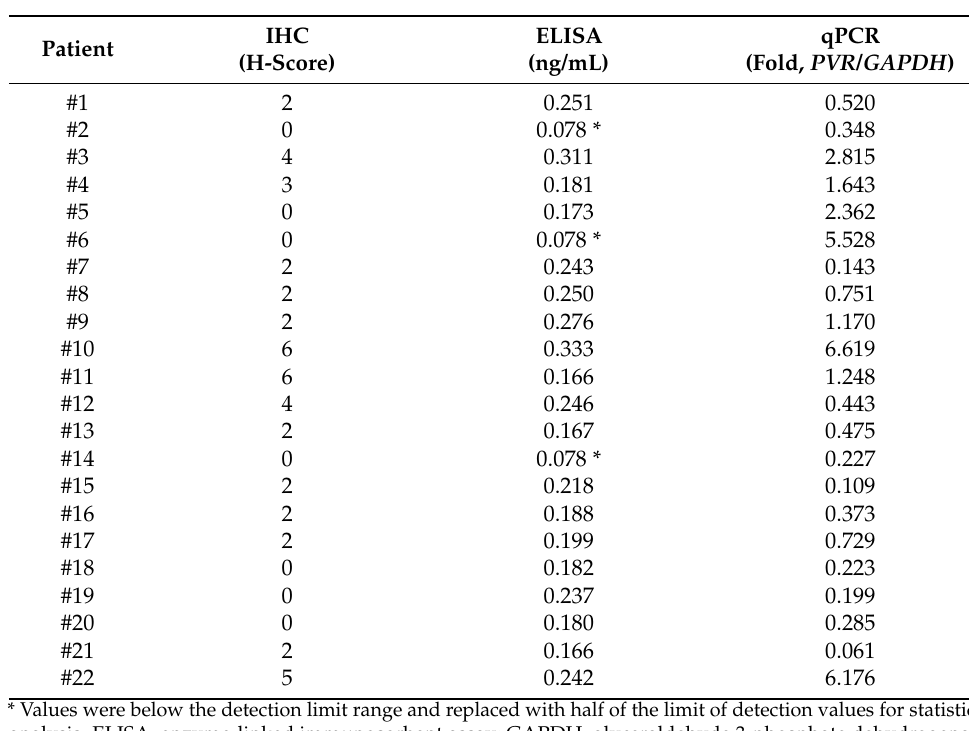
Table 1. Expression of PVR using different detection methods.